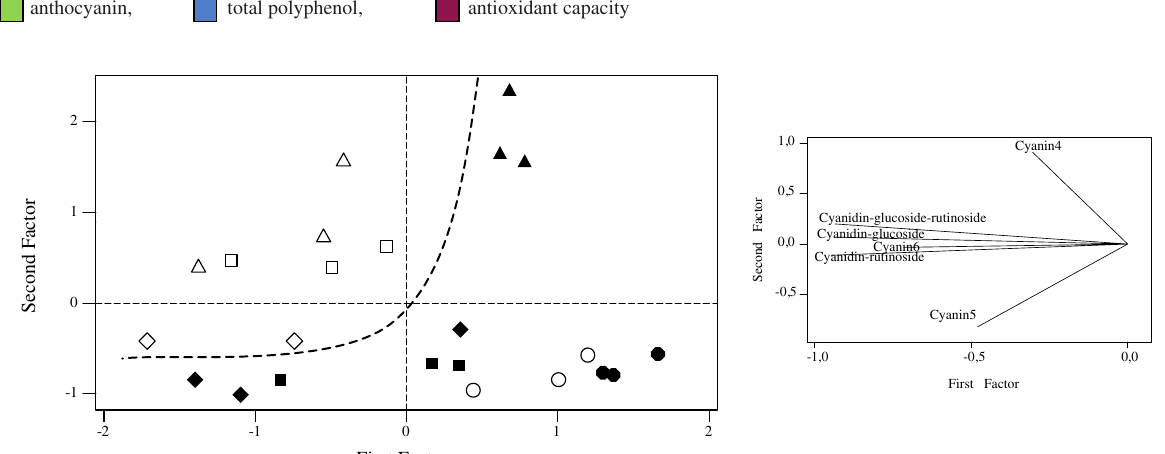
Figure 2.A: anthocyanin, total polyphenol content B: antioxidant capacity of sour cherry cultivars. anthocyanin, total polyphenol, antioxidant capacity